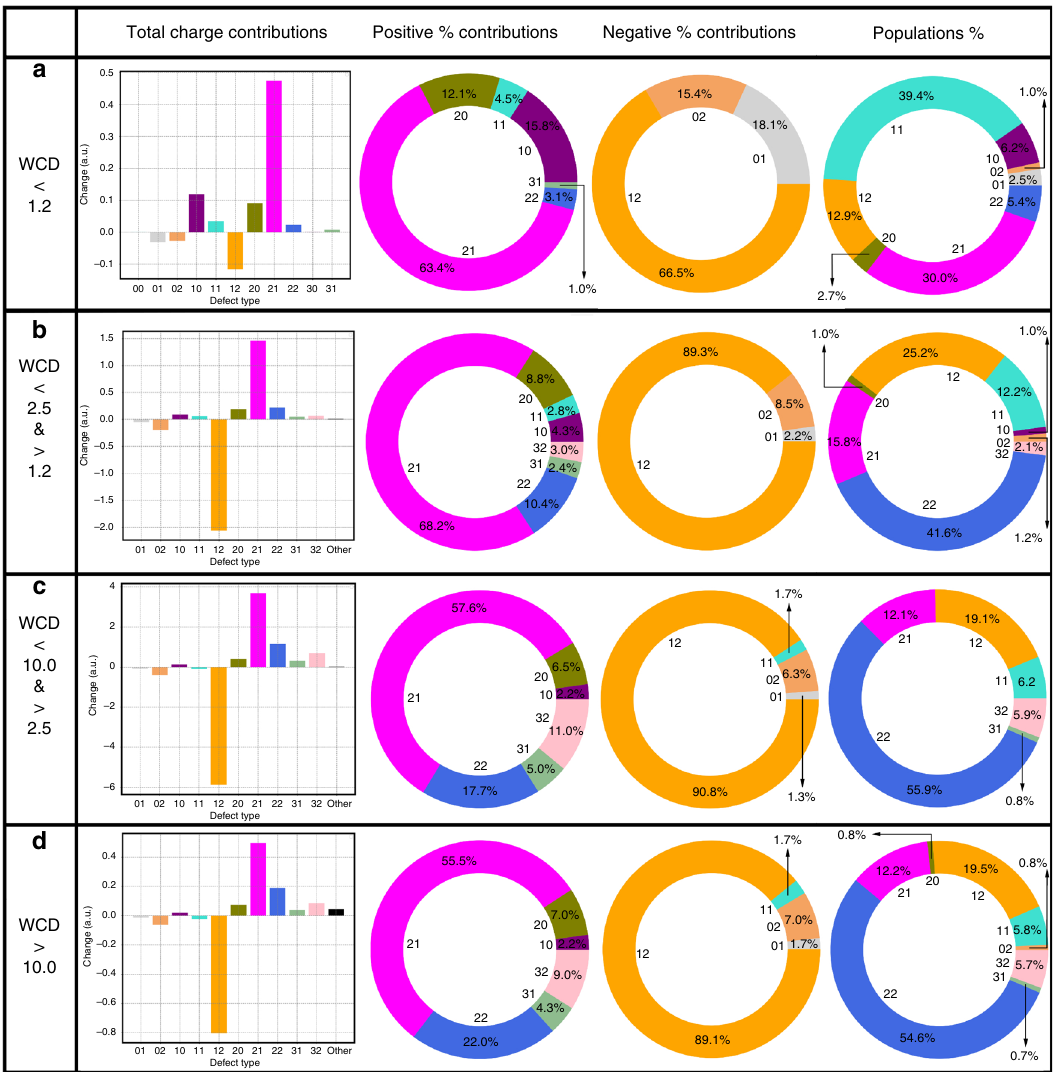
Fig. 5 Water/oil layer-by-layer charge and population contributions. Analysis of the water – oil interface layer-by-layer (as de fi ned in the main text) in terms of the average total charge contribution, percentage contribution to the positive charge, percentage contribution to the negative charge and percentage contribution to the overall population for each water coordination con fi guration. a reports the different contributions for the 1st layer, b for the second layer, c for the third layer and d for the fourth